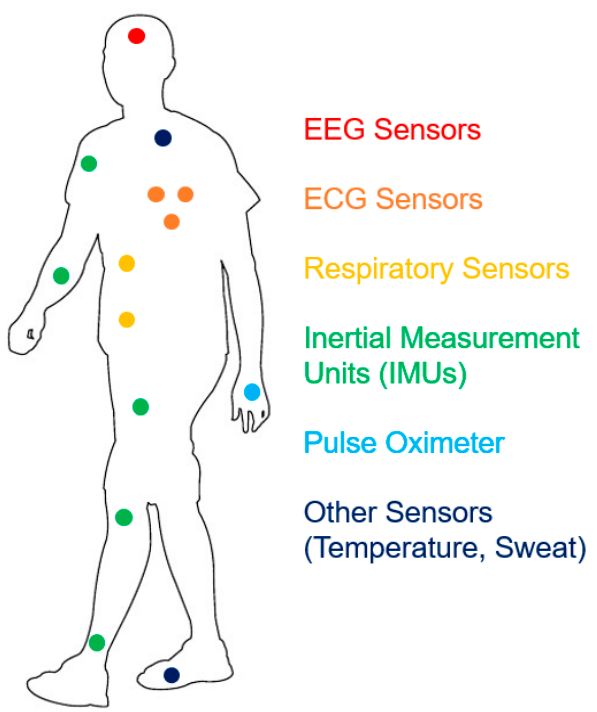
Figure 2. Typical placement sites of sensors that can be included in sensorized garments (ECGs, respiratory signal monitors, IMUs, pulse oximeters, other sensors).